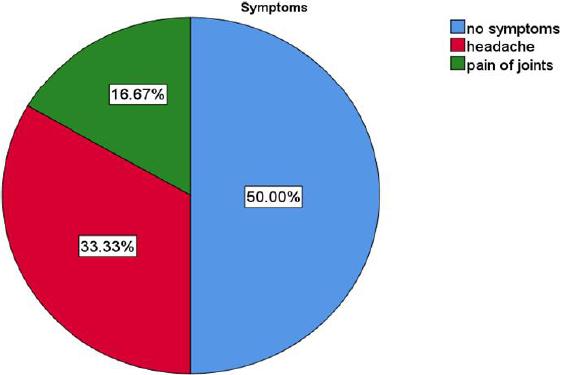
Figure 9. Potential infectious patients during the visit and spectrum of their symptoms.